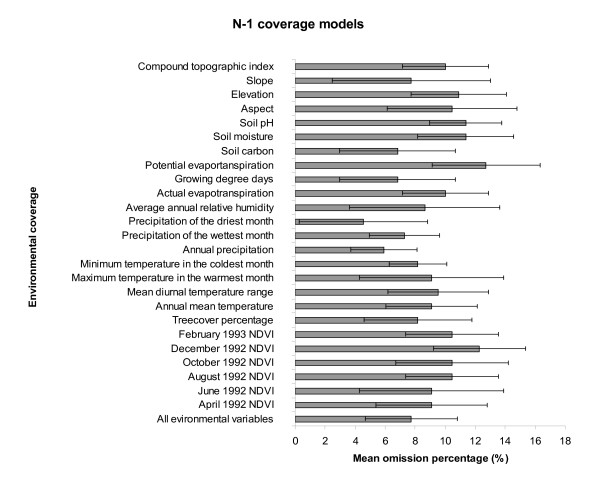
Relative contributions of N-1 environmental data sets. Horizontal bar graph presents a summary of results of N-1 coverage model analyses, indicating mean omission percentages (and standard deviations) calculated based on predictions of 10 best-subset models and independent testing points. Note that positive contribution by the variable is indicated by high values in the N-1 coverage models. At the bottom of the bar graph, mean omission percentage (and standard deviation) based on all environmental coverages is presented.